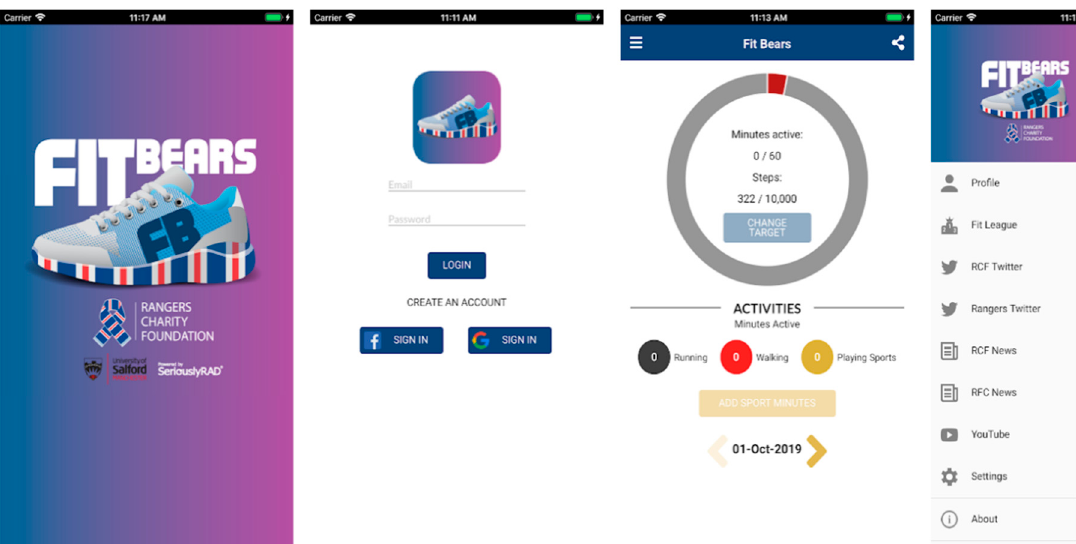
Figure 1. Screenshot of the FitBears Smartphone App.